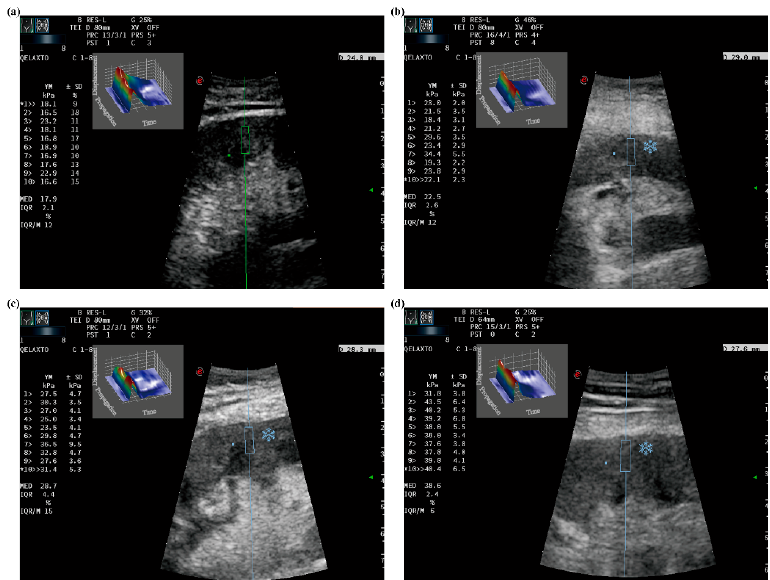
Figure 3. Measurements of p-SWE in renal transplants with different IF/TA stages: ( a ) IF/TA Grade 0, median = 17.9 kPa; ( b ) IF/TA Grade 1, median = 22.5 kPa; ( c ) IF/TA Grade 2, median = 28.7